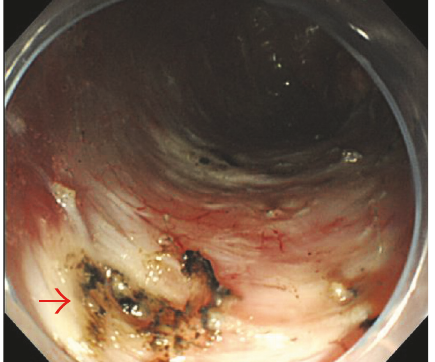
Figure 5: Case 5 underwent ESD for early gastric cancer in the lower third of the stomach. No perforation has been observed just after the completion of ESD. The arrow shows the perforated point on the next day after ESD.